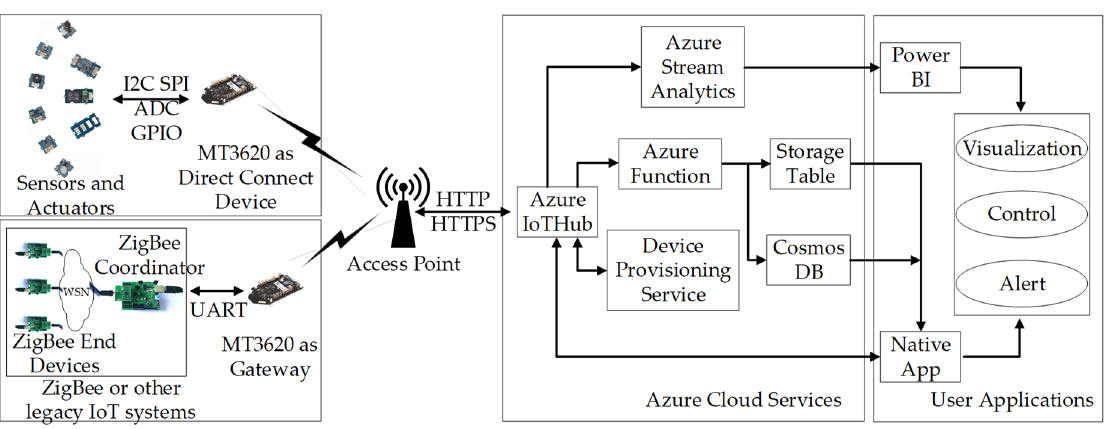
Figure 3. Proof of concept for the proposed solution.